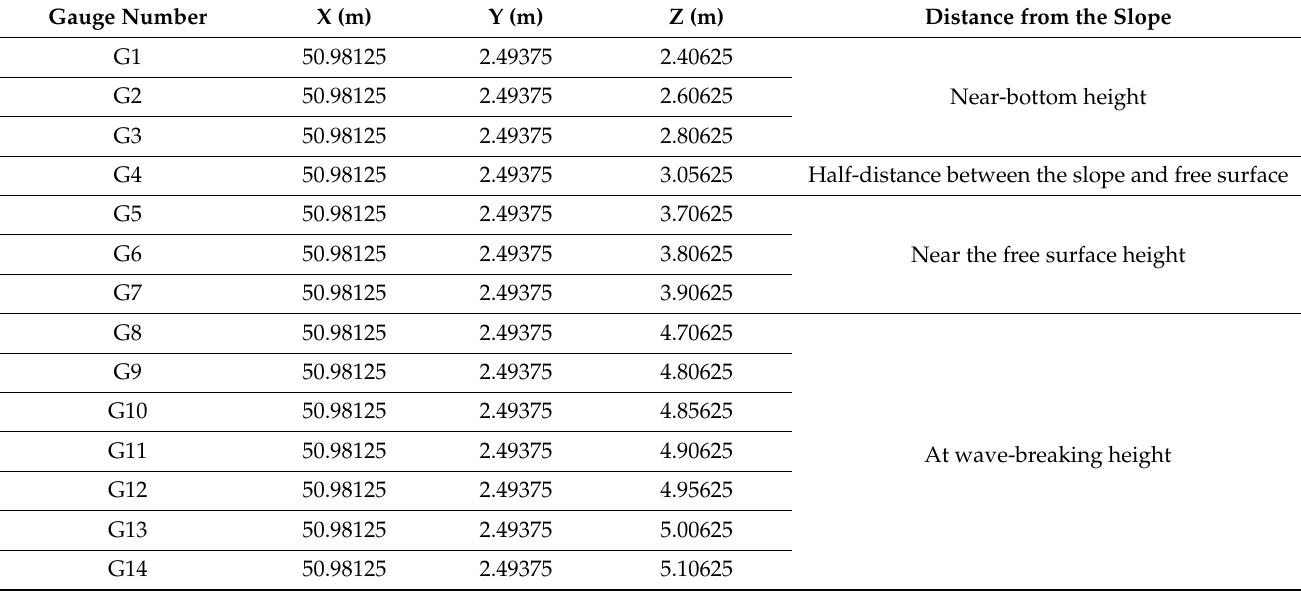
Table 3. Measuring positions for gauges placed near the substructures along the z -direction.